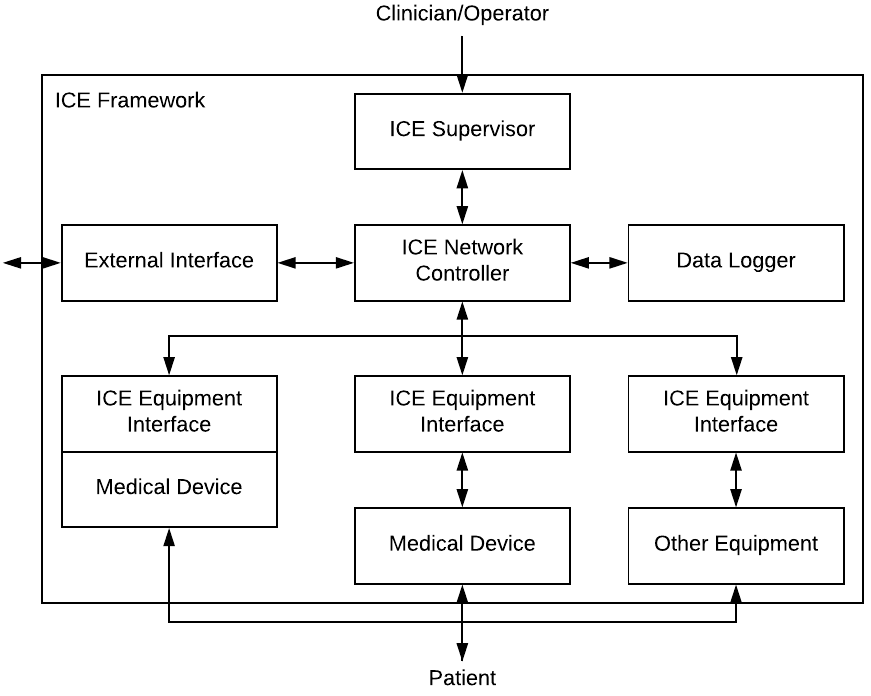
Figure 1. Elements composing the integrated clinical environment (ICE)